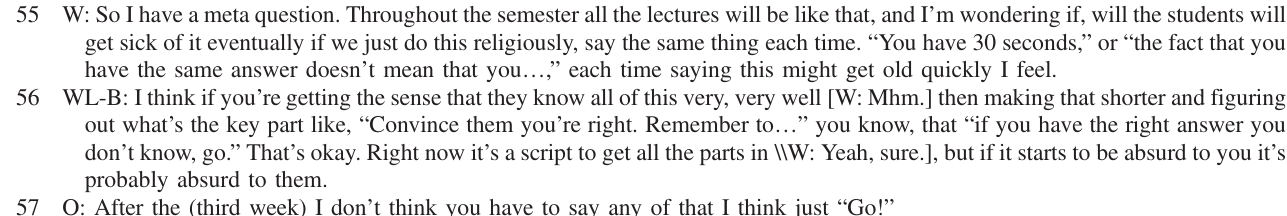
TABLE XI. Transcript of a conversation about the scriptedness of the TPS script in Session B. 55 W: So I have a meta question. Throughout the semester all the lectures will be like that, and I ’ m wondering if, will the students will get sick of it eventually if we just do this religiously, say the same thing each time. “ You have 30 seconds, ” or “ the fact that you have the same answer doesn ’ t mean that you … , ” each time saying this might get old quickly I feel. 56 WL-B: I think if you ’ re getting the sense that they know all of this very, very well [W: Mhm.] then making that shorter and figuring out what ’ s the key part like, “ Convince them you ’ re right. Remember to …” you know, that “ if you have the right answer you probably absurd to